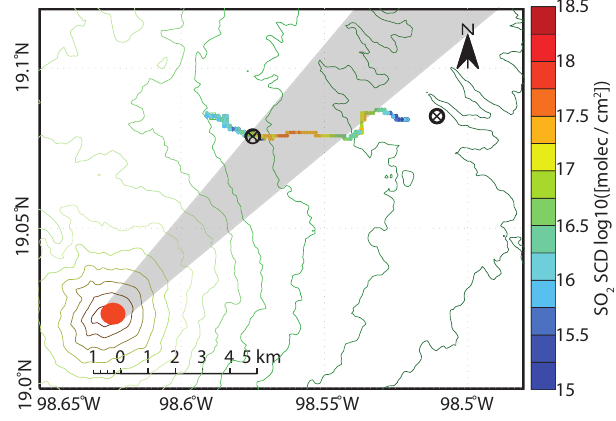
Fig. 4. Ground based measurements: An example of conducted car traverses is shown with measured SO 2 SCDs on a logarithmic scale. The locations of the stationary scanning instruments are marked by black circles. Popocat´epetl as a source is indicated with an orange dot at the lower left corner and its plume by the grey shaded